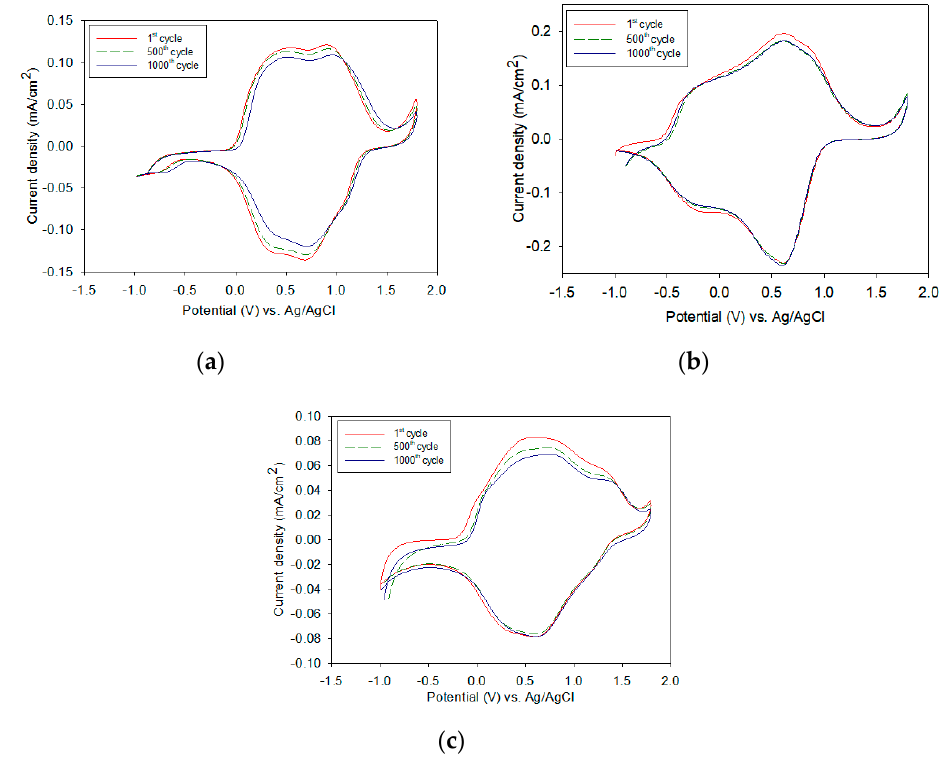
Figure 11. CV plots of: ( a ) PTTPP/PProDOT ‐ Et 2 ; ( b ) P(TTPP ‐ co ‐ DTC)/PProDOT ‐ Et 2 ; and ( c ) P(TTPP ‐ co ‐ DTP)/PProDOT ‐ Et 2